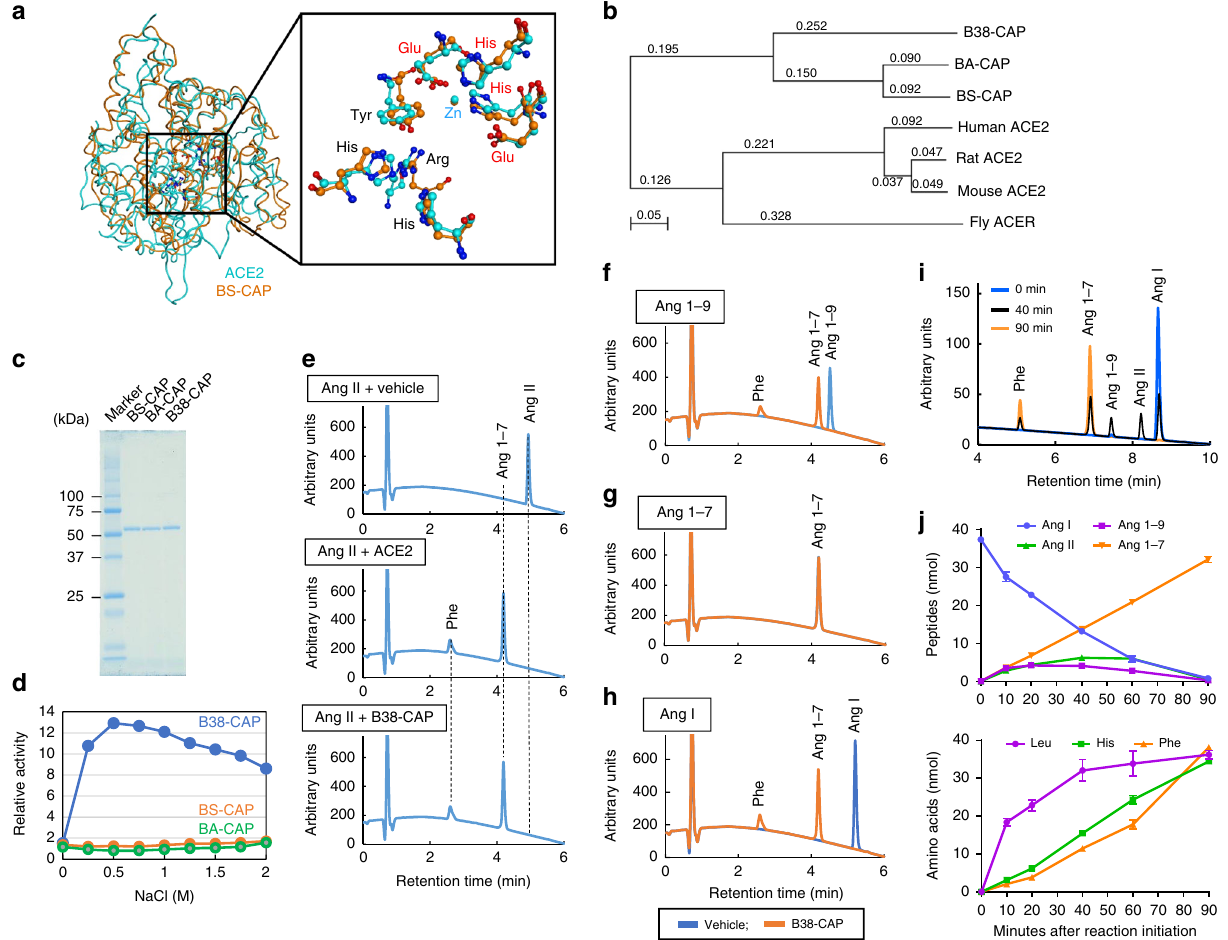
Fig. 1 B38-CAP, a bacteria-derived carboxypeptidase, is Angiotensin-converting enzyme 2 (ACE2)-like enzyme. a Crystal structures of BS-CAP and human ACE2 proteins. Inset: metal-coordinating residues (red) and substrate-binding residues (black) are shown. b Phylogenetic tree of ACE2 and bacterial ACE2-like carboxypeptidases. c SDS-PAGE analysis of recombinant proteins of BS-CAP, BA-CAP, and B38-CAP. d Dependence of ACE2-like proteolytic activity of BS-CAP, BA-CAP, and B38-CAP on anion concentration. ACE2 activity was measured with hydrolysis rate of the fl uorogenic ACE2 substrate Nma-His-Pro-Lys(Dnp). e – h HPLC analysis of B38-CAP-treated angiotensin peptides. Ang II ( e ), Ang 1 – 9 ( f ), Ang 1 – 7 ( g ), or Ang I ( h ) (5 nmol each) was incubated with vehicle, recombinant B38-CAP protein, or recombinant ACE2 protein (5 μ g each) for 90 min, then subjected to HPLC analysis. i , j Kinetic analysis for hydrolysis of Ang I with B38-CAP. HPLC analysis of angiotensin peptides generated after incubating Ang I with B38-CAP ( i , j , upper panel). Amino acids in the same samples were quanti fi ed with LC-MS system ( j , lower panel). Experiments were repeated more than three times and representative chromatography charts are shown. j Values are means± SEM. n = 3 independent experiments.